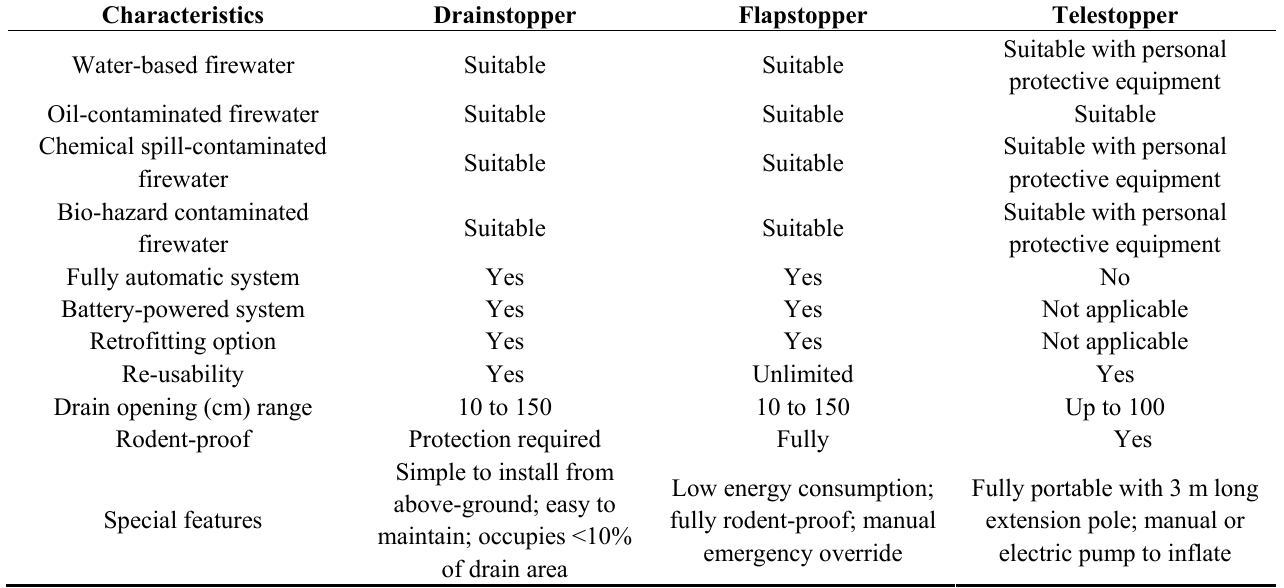
Table 1. Overview of commercially available firewater in-drain spill and pollution containment system examples (after